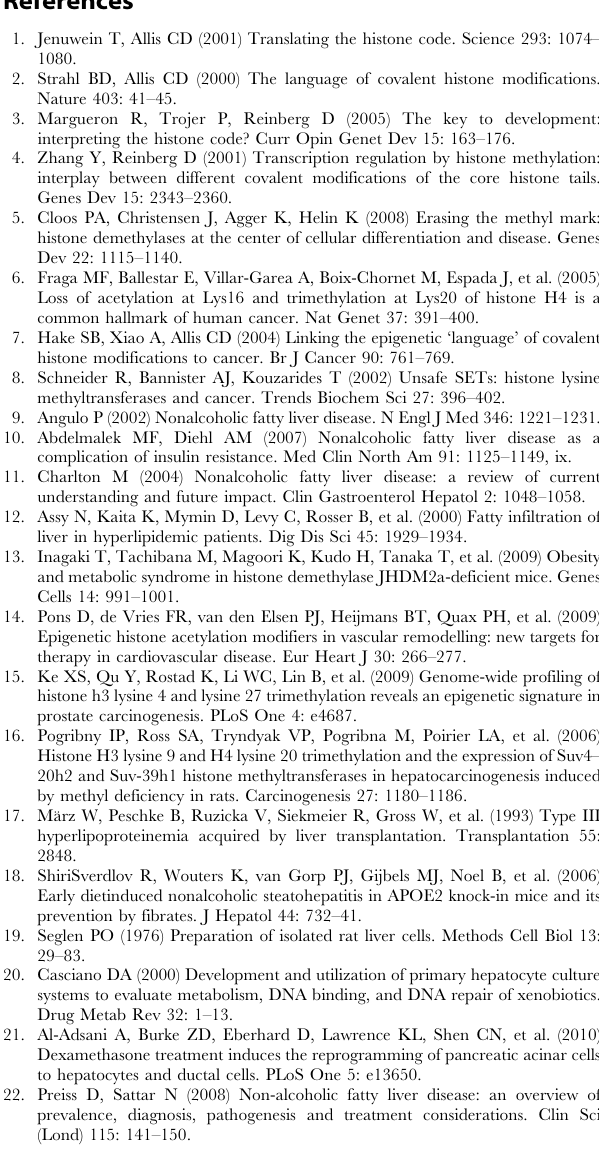
labeling reactions and microarray hybridization. Figure S2 Primary hepatocytes isolated from C57BL/6J mice. Primary hepatocytes were obtained by perfusion of the livers of C57BL/6J mice with collagenase type IV. (A) Photomi- crograph of a monolayer of the isolated primary mouse hepatocytes (magnification, 6 40). (B) mRNA levels of the typical hepatocyte markers albumin and transferrin assessed by RT-PCR analysis. Figure S3 Chromosomal distribution of H3K9me3 and H3K4me3 targets. Each dot indicates the mean log2 value of signals in the H3K9- or H3K4-trimethylated region of their corresponding gene.